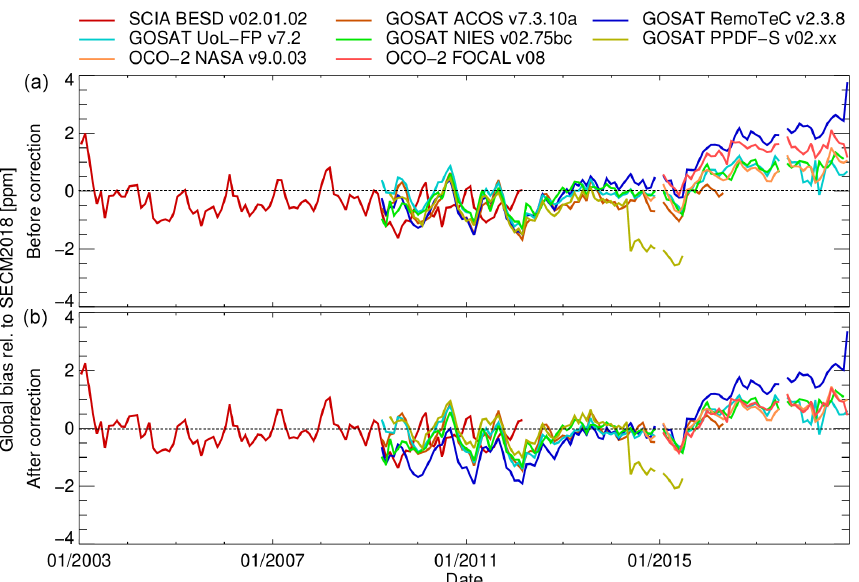
Figure 5. Global bias correction as applied by EMMA to the individual satellite XCO 2 input data products. Panel (a) shows the difference relative to the SECM2018 model (computed as satellite – model) before the correction and (b) shows the difference after correction.